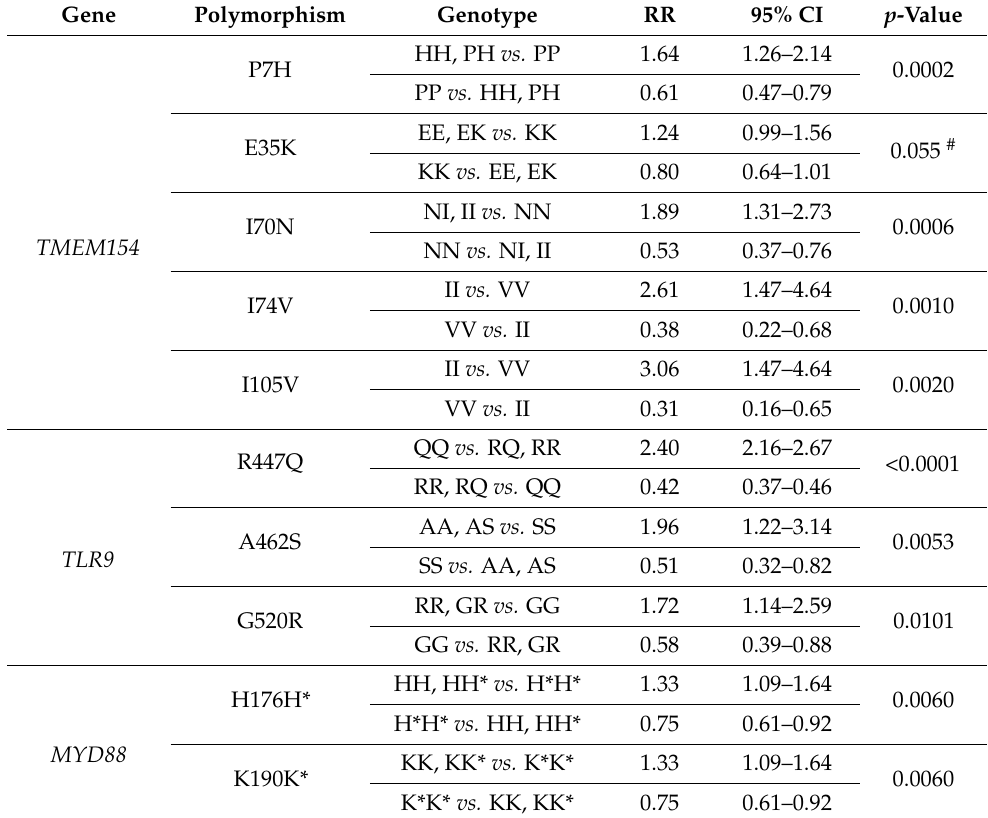
Table 2. Significant relative risk of infection for TMEM154 , TLR9 and MYD88 genotypes. Gene Polymorphism Genotype RR 95% CI p -Value HH, PH vs. P7H